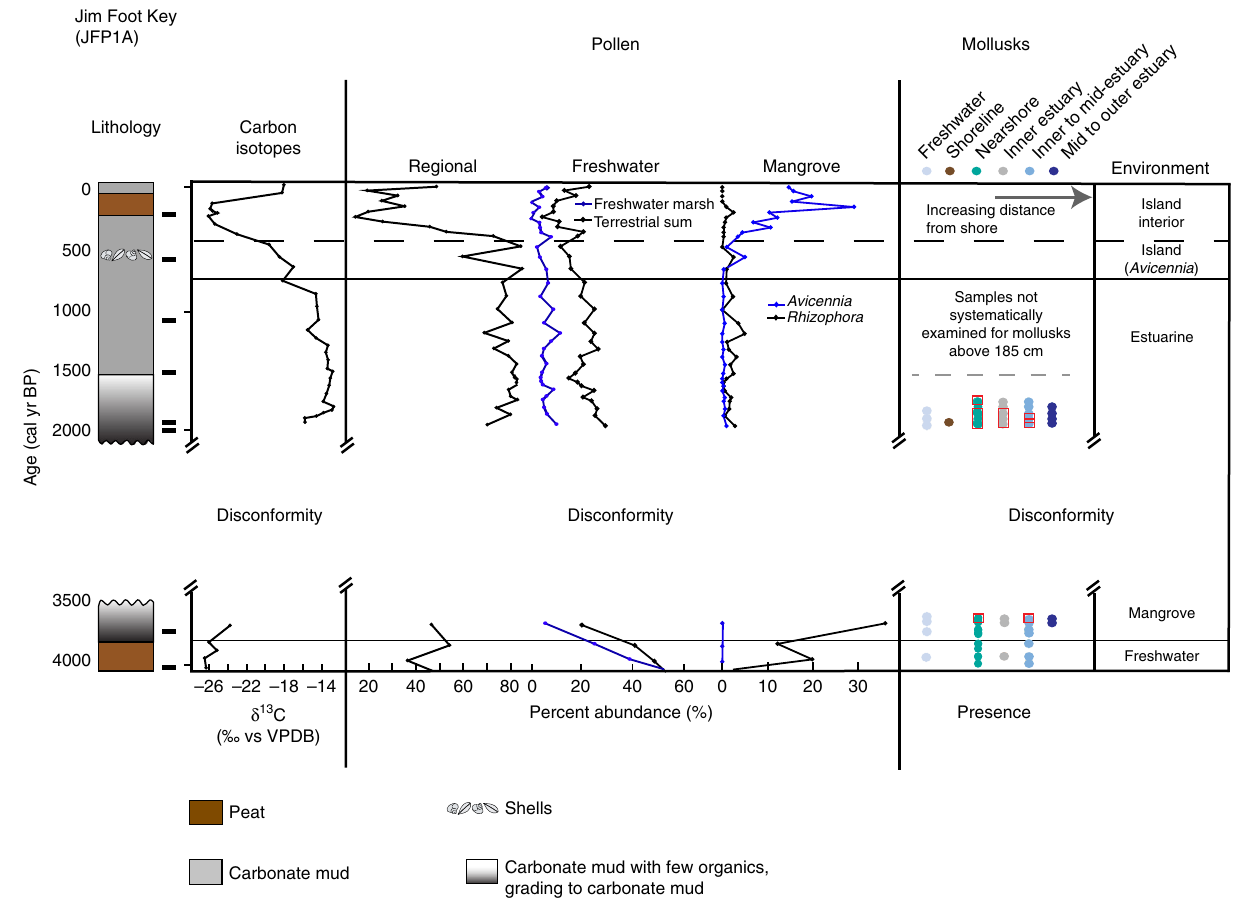
Fig. 4 Core summary diagram for Jim Foot (JF) Carbon isotopes, selected pollen groups, and presence of mollusks. Regional pollen includes Pinus (pine) and Quercus (oak). Freshwater marsh sums include Poaceae, Cyperaceae, Nymphaea, Typha, Rhynchus, Cladium, Schoenoplectus, Sagittaria, Crinum , and Amaryllidaceae. Terrestrial sum includes all taxa, except the regional taxa and mangrove taxa, as well as Batis maritima and Amaranthaceae. Mollusk presence is shown in order of increasing salt-water/estuarine habitat and distance from shoreline from left to right. Red squares indicate abundance or dominance in a given sample. Radiocarbon age control shown by black rectangle next to the